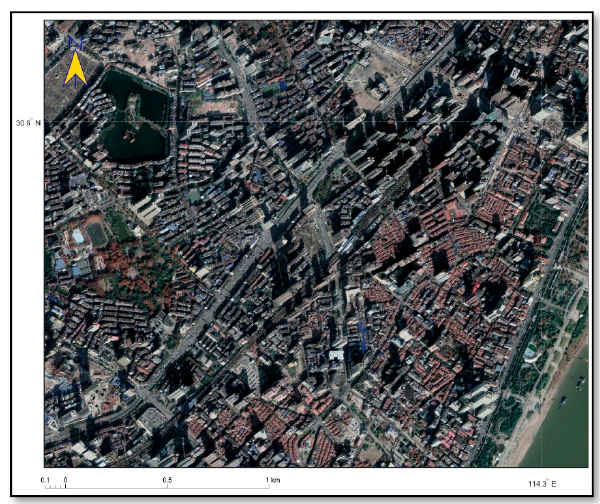
Figure 1. Satellite image of study area.